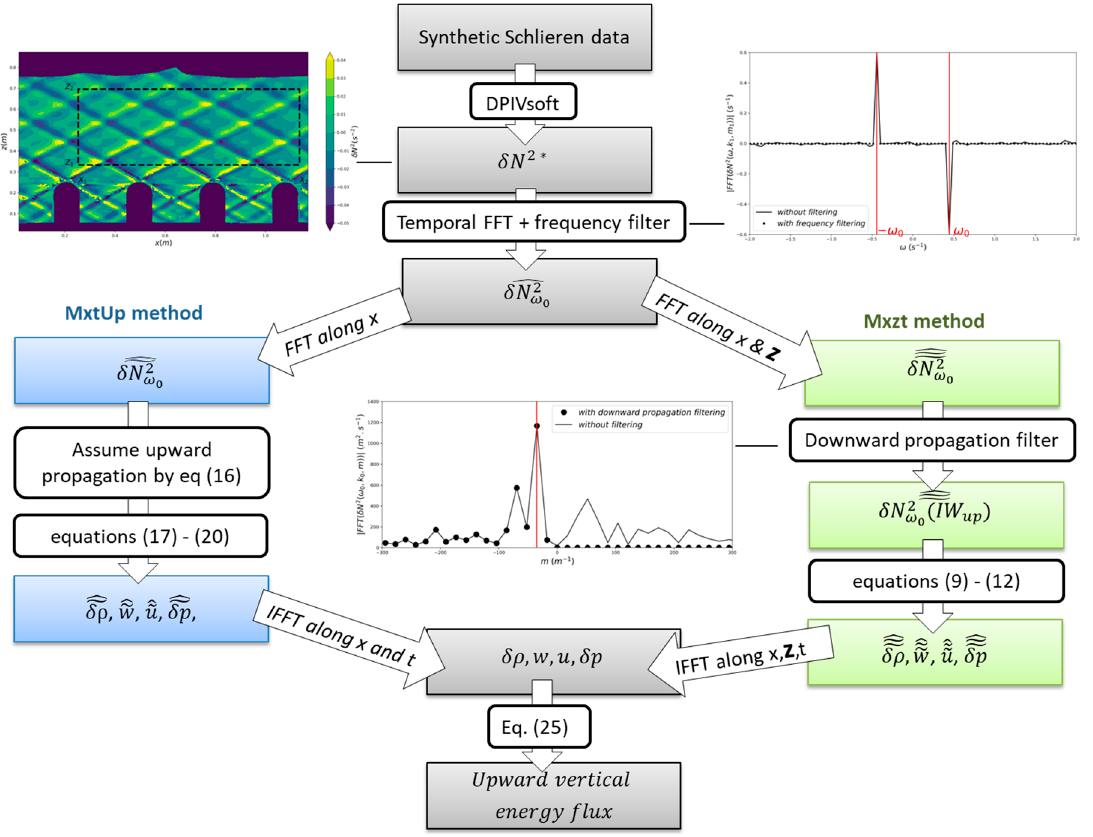
Figure 1. Schematic chart of the Mxzt and MxtUp methods for calculating the density anomaly and the upward vertical energy flux from synthetic Schlieren data. * When applied to internal wave fields observed in the laboratory experiments (Section 3.2), a moving mean is applied along the z axis to the experimental data ( δ N 2 ) in order to reduce the small-scale noise.